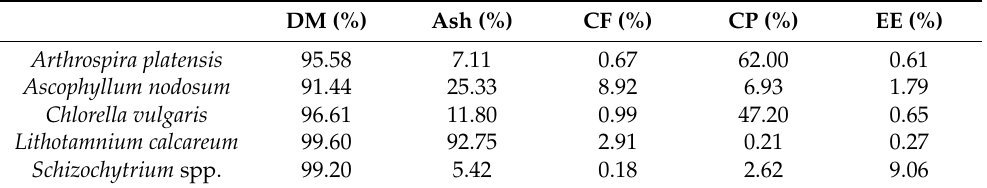
Table 2. Chemical composition of dried samples of Arthrospira platensis ; Ascophyllum nodosum ; Chlorella vulgaris ; Lithothamnium calcareum and Schizochytrium spp.